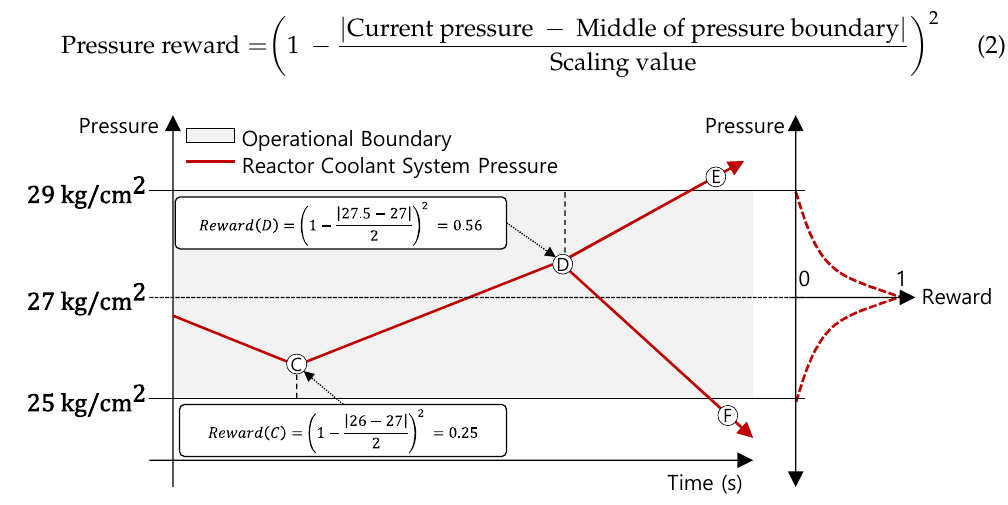
Figure 7. Pressure reward algorithm for achieving operational goals.